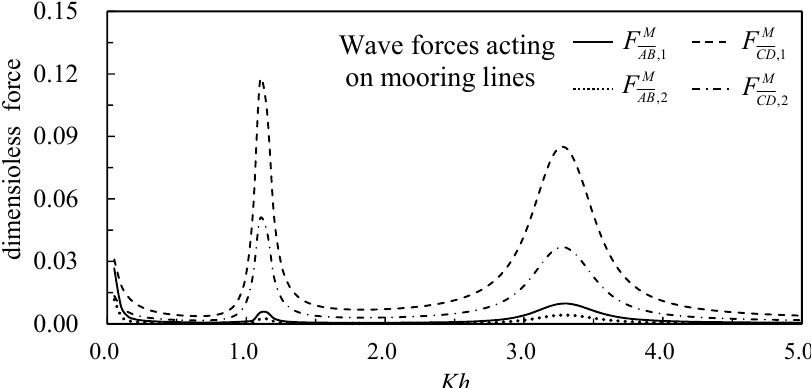
Figure 12. Wave forces on the mooring lines versus relative water depth ( d 1 / h = 0.25, (cid:96) / h = 0.2, a / h = 0.3, C D = 2.0, and C M = 2.0).